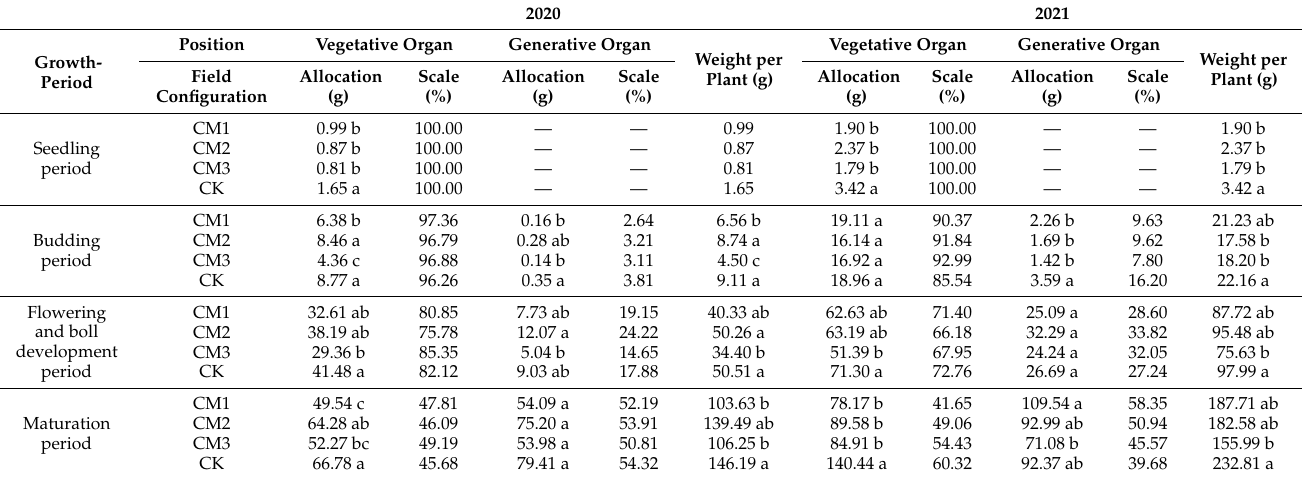
Table 2. Dry matter accumulation and distribution per plant at different growth periods of